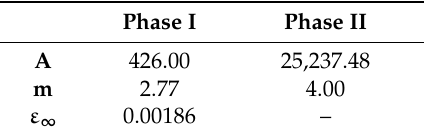
Table 3. Fatigue damage model